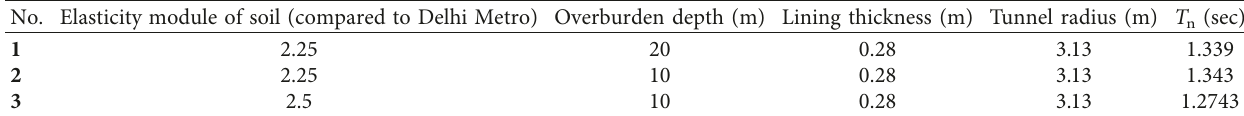
Table 8: Properties of models that presence of the tunnel amplifies the acceleration spectrum at a distance of 10.5 m from the center of the tunnel projection onto the ground surface.